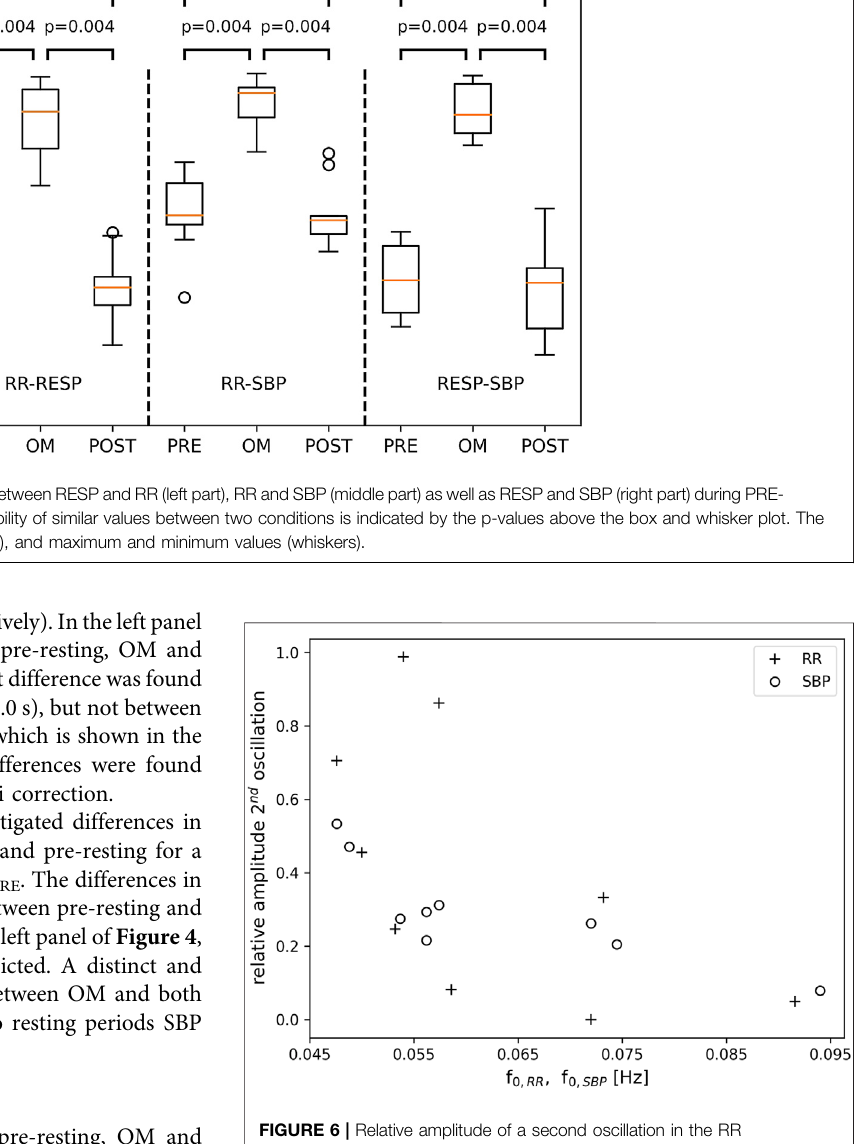
FIGURE 6 | Relative amplitude of a second oscillation in the RR tachogram (+) and SBP (o) as a function of the frequency of the fi rst harmonic f 0,RR and f 0,SBP , respectively. Note, that the fi rst harmonic in RR and SBP corresponds to the breathing